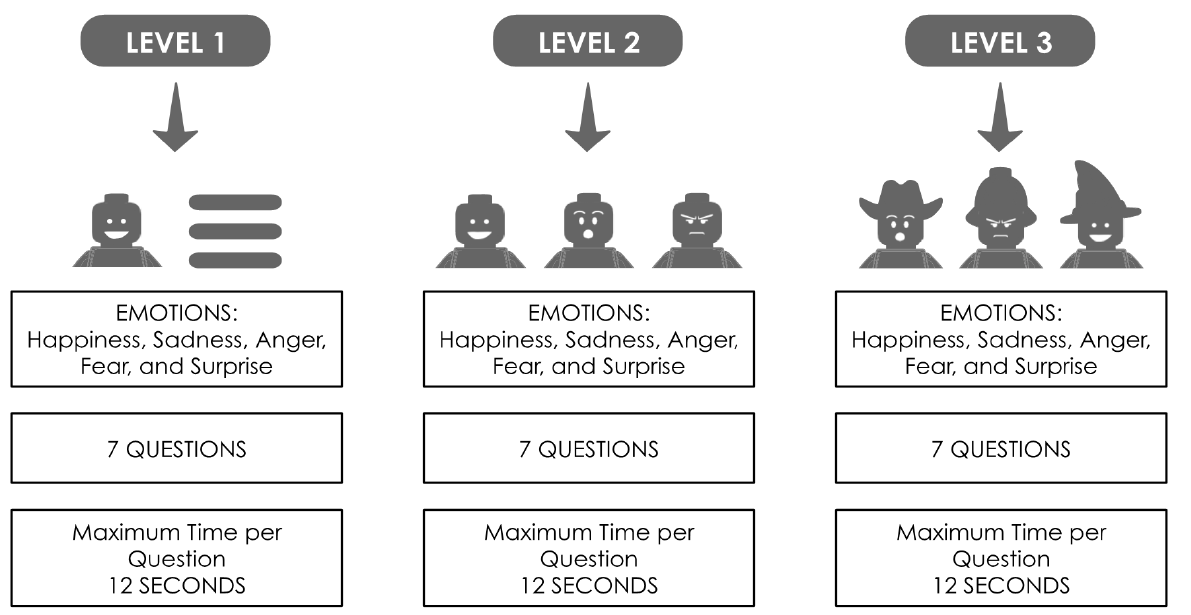
Figure 2. ‘Feeling Master’ summary of levels.